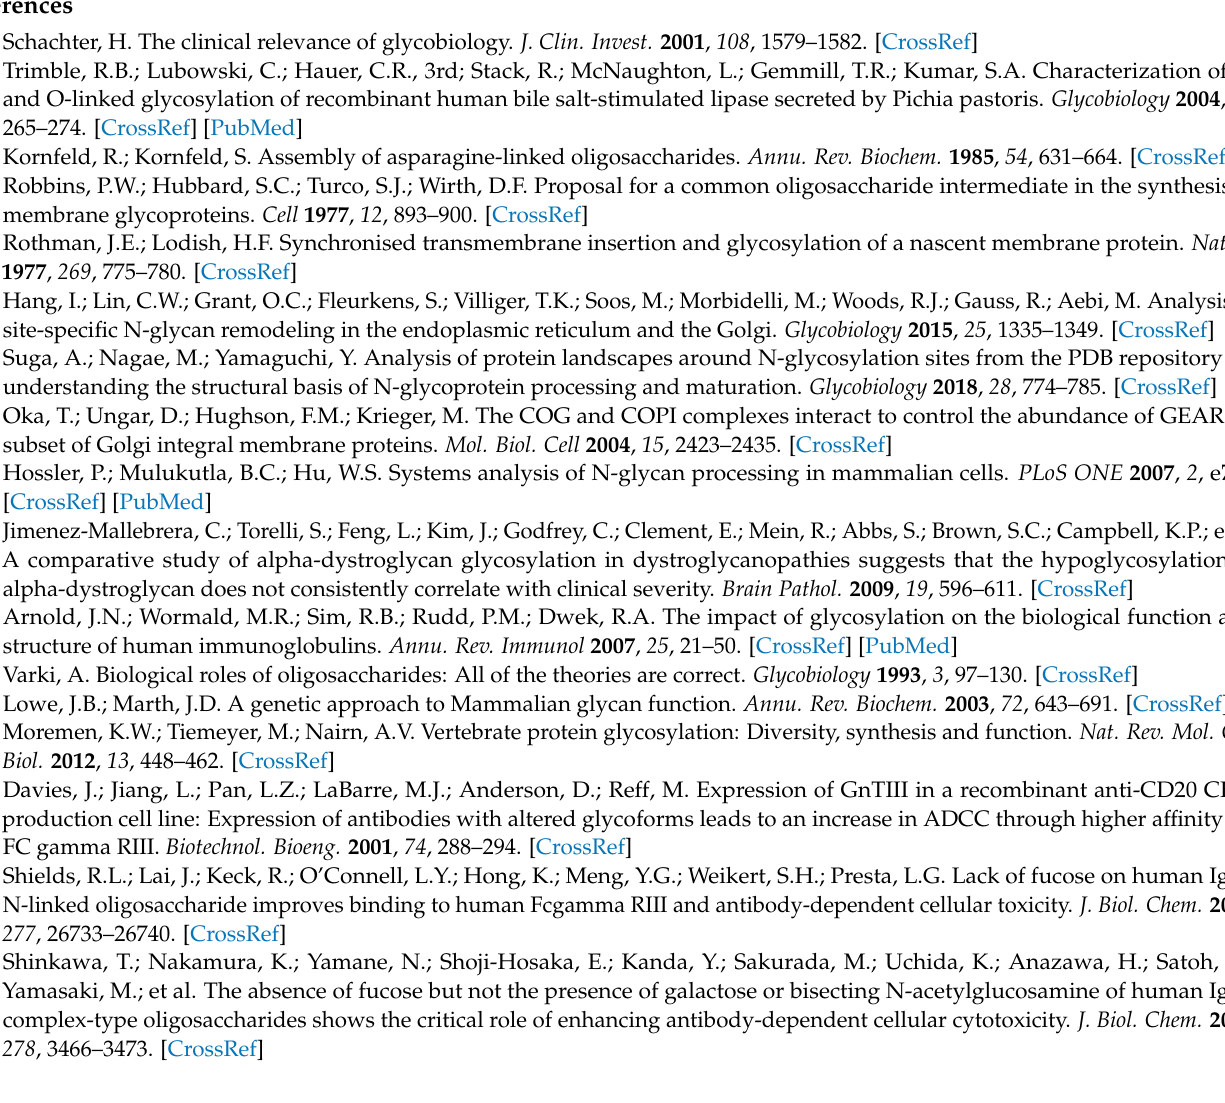
Figure S4: Plots of the average T2 relaxation for proteins and glycans; Figure S5: Intensity regions used in Table 1 for the 1H-13C HSQC and the HSQC-TOCSY for RNase B Man5. Table S1: Linewidths and estimated T2 relaxation values for protein C α ’s and glycan anomeric ring 1H-13C